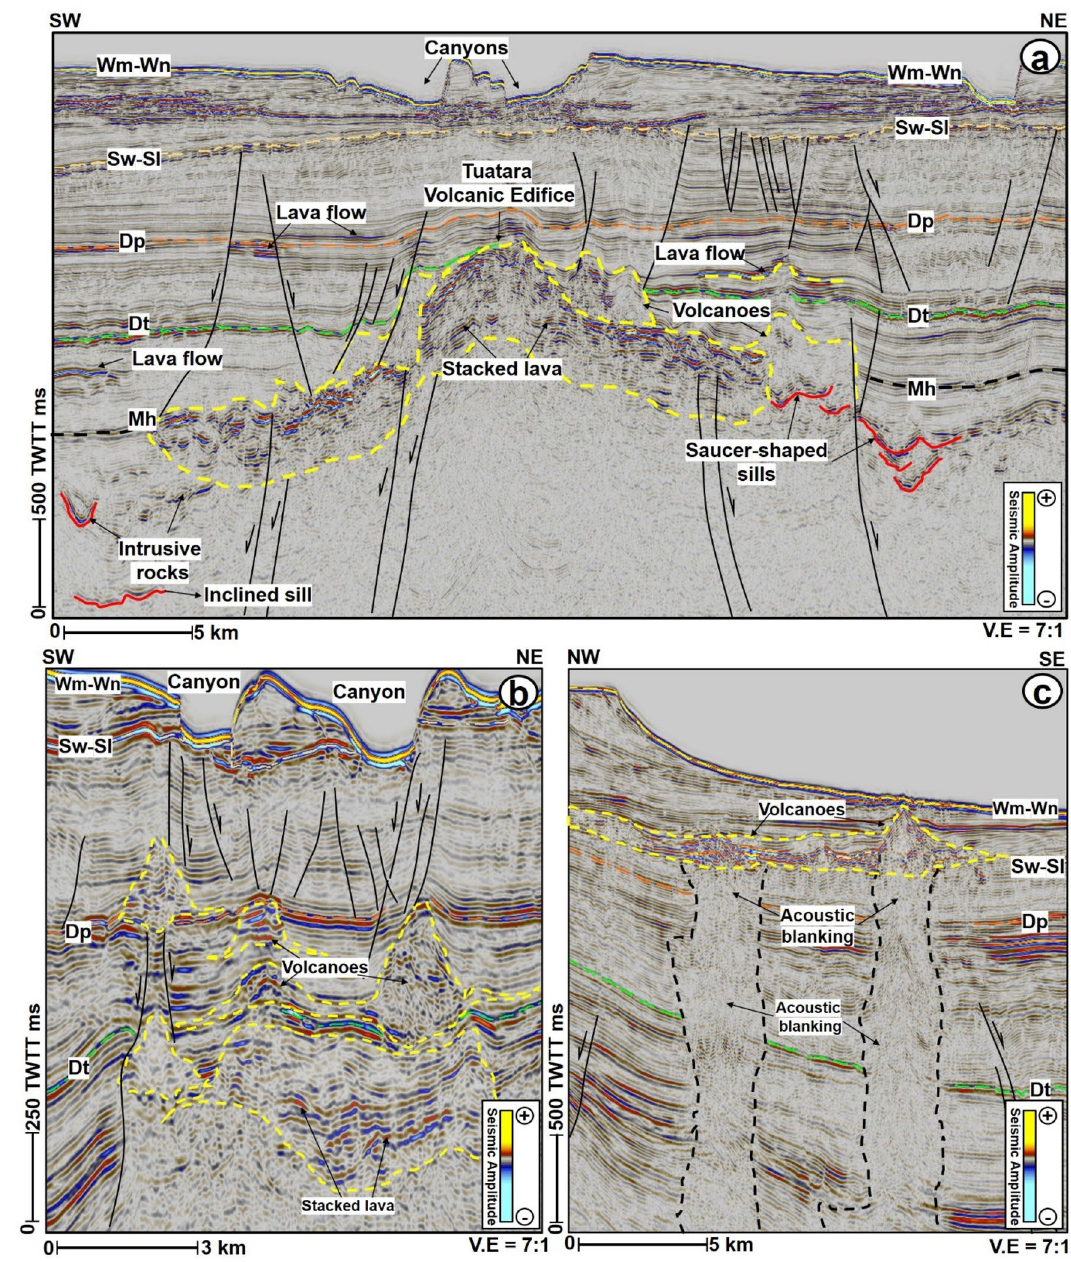
Figure 10. ( a ) Interpreted SW-NE seismic section showing the architectural outlook of the Tuatara Volcanic Field (TVF) of 32 . The volcanoes here are mostly interpreted within the Paleocene strata, especially on the eastern flank of the TVF. Seismic sections showing other volcanoes identified in the study area. These include ( b ) those that are vertically and laterally stacked within the Eocene strata and ( d ); those seen emplaced within the Miocene to Pleistocene strata. These volcanoes are also commonly found with lava flows and intrusive rocks. The uninterpreted seismic sections are provided in the supplementary document